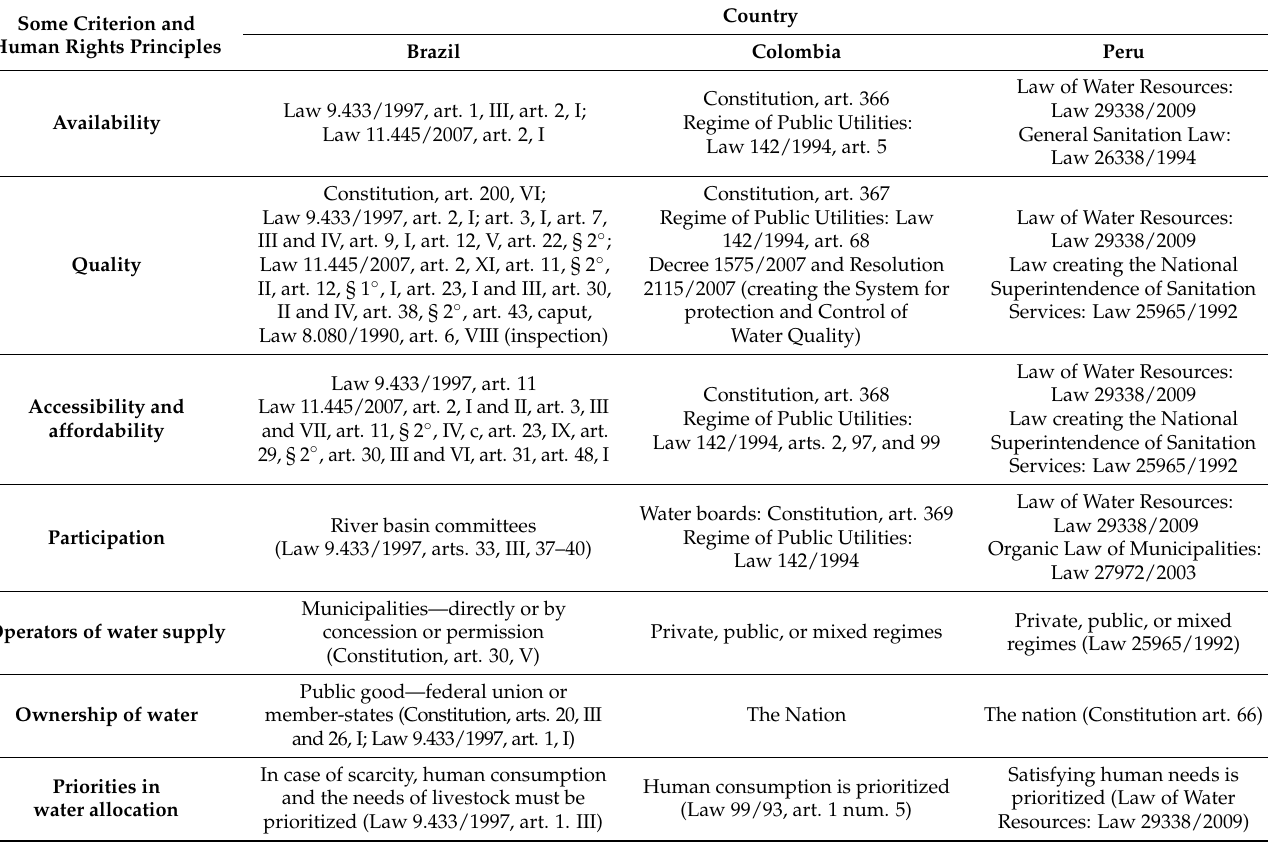
Table 2. Pre-existing legal framework for the right to water in the selected countries